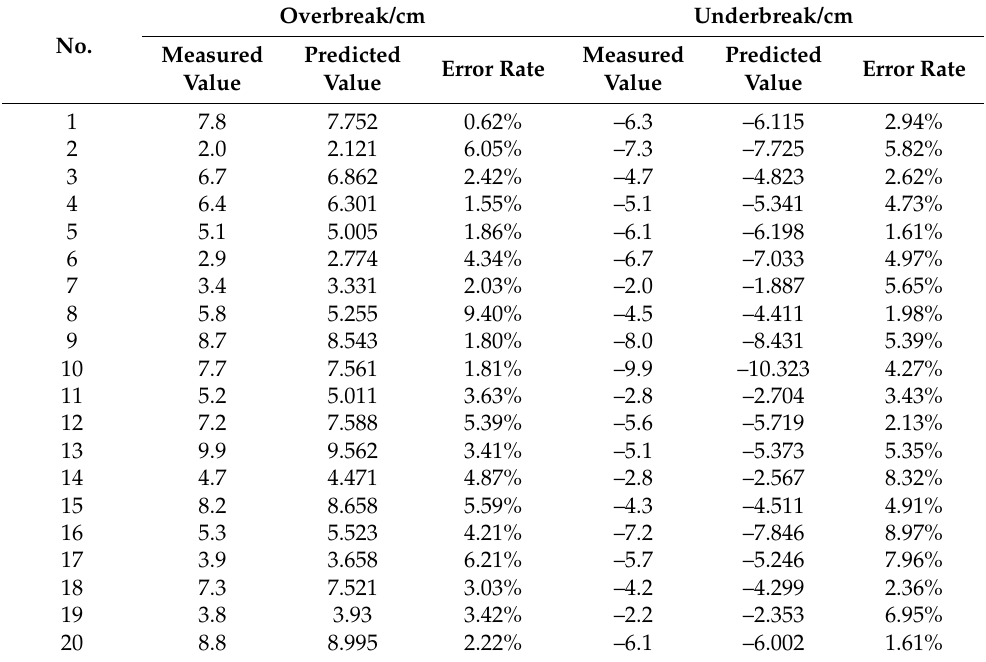
Table 3. The accuracy of the prediction in training data.